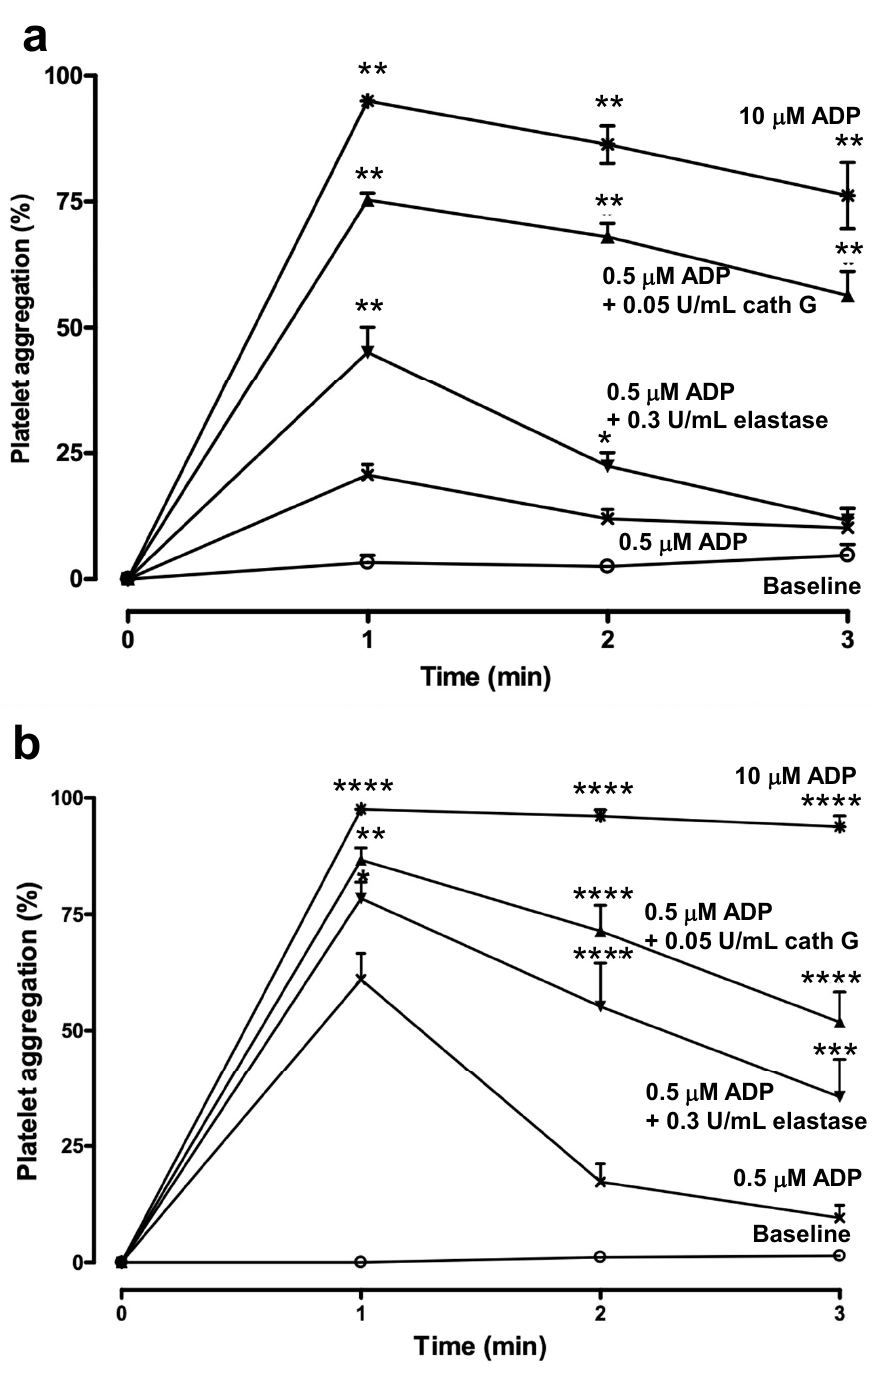
Figure 5. Whole blood aggregation in C57BL/6 WT vs. C57BL/6 PAR4 − / − mice. ( a ) Platelet aggrega- tion curves for C57BL/6 WT ( a ) and C57BL/6 PAR4 − / − mouse blood ( b ), in the absence of added agonist (Baseline, open circles), or upon addition of 0.5 µ M ADP, alone or associated with 0.05 U/mL cathepsin or 0.3 U/mL elastase G, added during a 3 min pretreatment a 37 ◦ C; the tracing for 10 µ M ADP is also shown. Data are mean ± SEM ( n = 4–12 in each group). Statistical analysis was by one-way ANOVA, followed by Newman–Keuls multiple-comparison test (( a ) * p < 0.01, ** p < 0.0001 vs. tracing for 0.5 µ M ADP; ( b ) * p < 0.05, ** p < 0.01, *** p < 0.001, **** p < 0.0001 vs. tracing for 0.5 µ M ADP). Platelet aggregation is calculated from residual platelet numbers at the indicated time